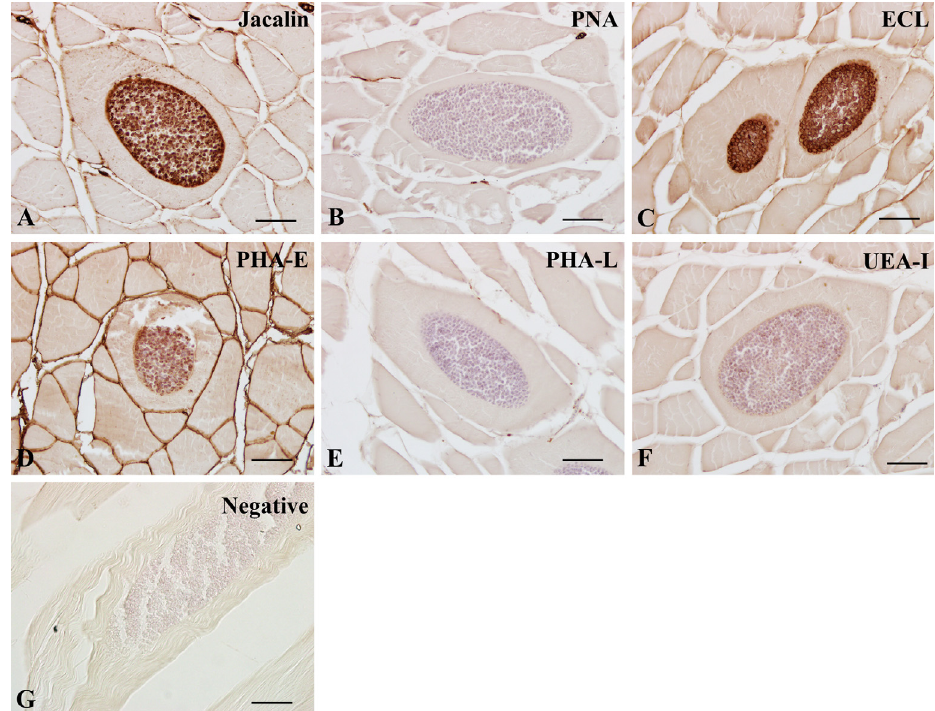
Figure 4. Lectin histochemical findings of galactose/N-acetylgalactosamine (Jacalin, PNA, ECL), oligosaccharide (PHA-E, PHA-L), and fucose groups (UEA-I) in Kudoa septempunctata -infected muscles. A, Jacalin; B, PNA; C, ECL; D, PHA-E; E, PHA-L; F, UEA-I; G, Negative control (UEA-I preabsorbed with 0.1 M L-fucose). Scale bars in (A)–(G) represent 20 l m.